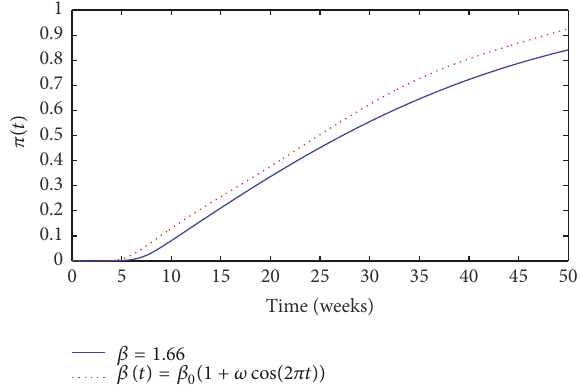
Figure 6: Variation of the current economic burden with respect to time under constant infection rate, 𝛽 (in blue), and the seasonal infection rate, 𝛽(𝑡) (in red), defined in (4). Here 𝛽 0 = 1.66 and 𝜔 = 0.28